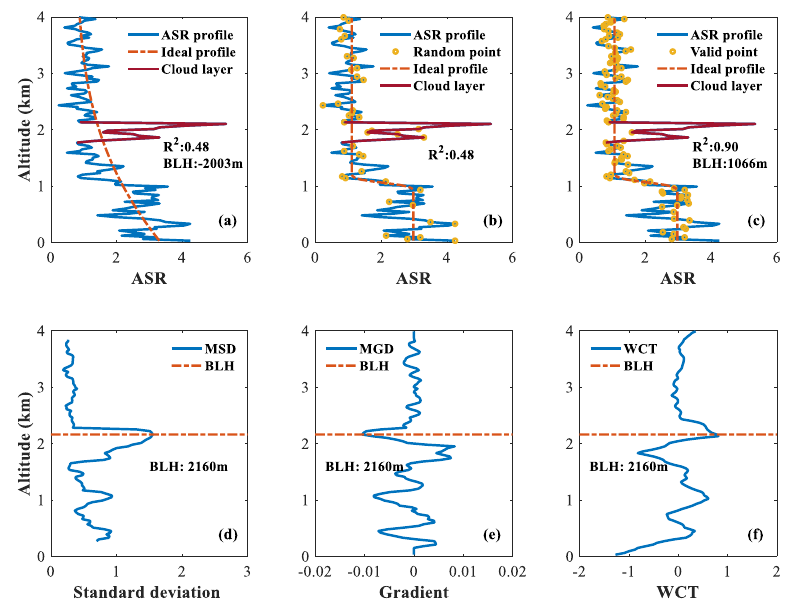
Figure 3. PBLHs determined with ( a ) IPF, ( c ) RANSAF, ( d ) MSD, ( e ) MGD, and ( f ) WCT methods from a simulated ASR. ( b ) Ideal profile fitted by the randomly selected points.